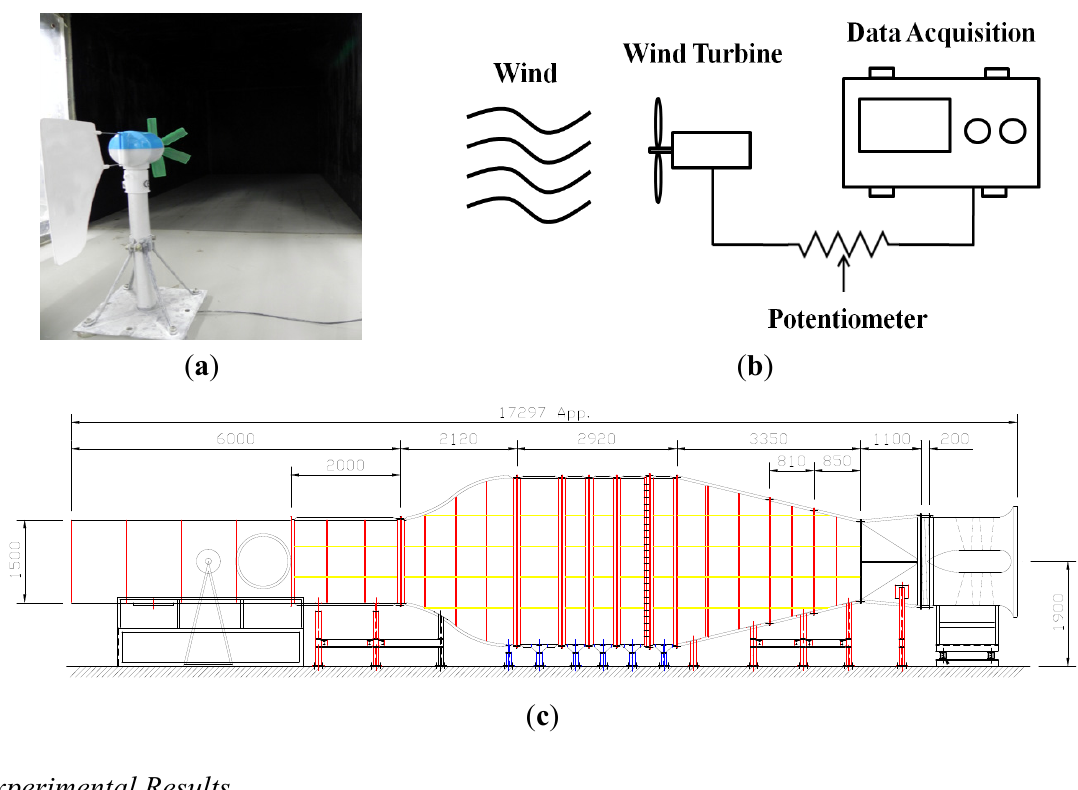
Figure 8. Experimental setup: ( a ) wind turbine in the wind tunnel; ( b ) configuration of the experiment; ( c ) wind tunnel